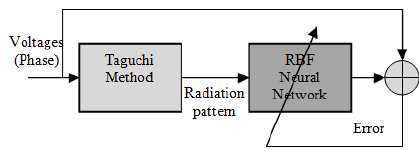
FIGURE 22. Neural network training procedure.